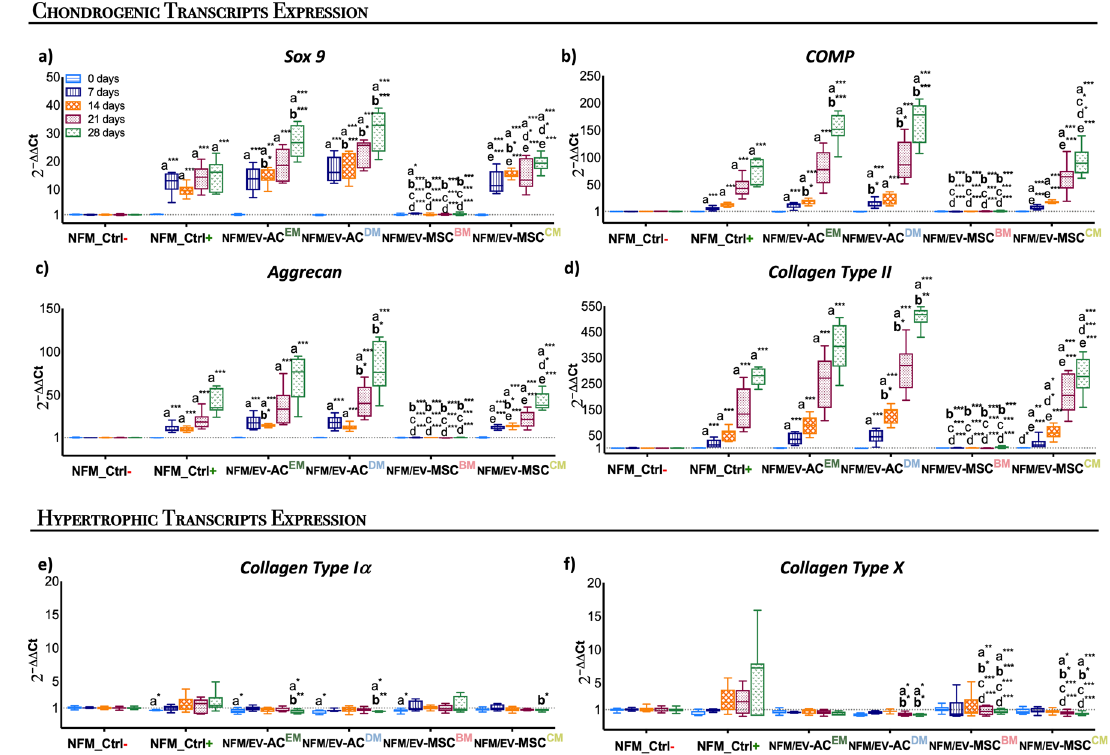
Fig. 5 Temporal gene expression of cultured hBM-MSCs. Relative expression of chondrogenic (i.e., Sox9 ( a ), COMP ( b ), Aggrecan ( c ), and Collagen type II ( d )) and hypertrophic (i.e., Collagen type I α ( e ), Collagen type X ( f )) transcripts by hBM-MSCs cultured on biofunctional nano fi brous systems comprising EVs derived from different sources (i.e., NFM/EV-AC EM , NFM/EV-AC DM , NFM/EV-MSC BM , and NFM/EV-MSC CM ), under basal culture conditions. hBM-MSCs cultured on non-biofunctionalized nano fi brous substrates under basal medium ( NFM_Ctrl- ) or chondrogenic medium ( NFM_Ctrl + ) were used as controls. Data are represented in box plot and analyzed by Kruskal – Wallis test, followed by Tukey ’ s HSD test (* p < 0.01; ** p < 0.001; *** p < 0.0001): a denotes signi fi cant differences compared to NFM_Ctrl- ; b denotes signi fi cant differences compared to NFM_Ctrl + ; c denotes signi fi cant differences c ompared to NFM/EV-AC EM ; d denotes signi fi cant differences compared to NFM/EV-AC DM ; e denotes signi fi cant differences compared to NFM/EV-MSC BM